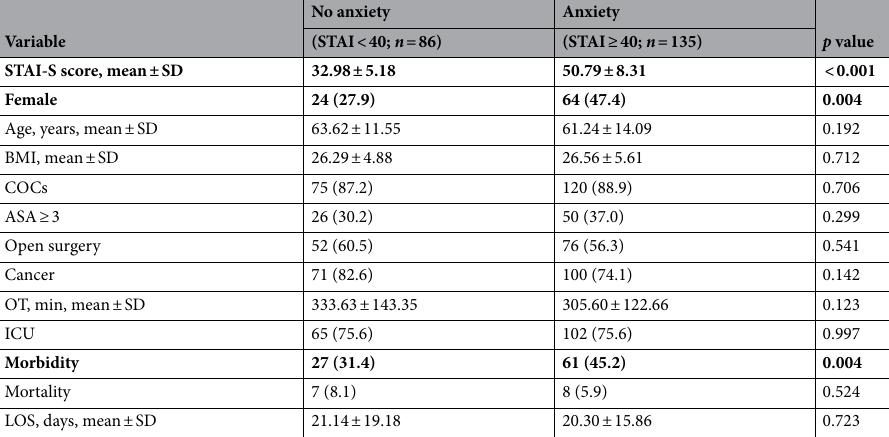
Table 5. Baseline patient characteristics and main outcomes for subgroup of patients who underwent 3 specific complex procedures ( N = 221). STAI, State-Trait Anxiety inventory (STAI-S = state anxiety); BMI, body mass index in kg/m 2 ; SD, standard deviation; ASA, the American society of anesthesiologists physical status classification; COCs, comorbid conditions; pp, per patient; OT, operative time; ICU, intensive care unit required; LOS, hospital length of stay. Numbers in bracket indicate values presented in n (%) by group unless noted otherwise. P values represent the difference between the two groups. Significant values are in